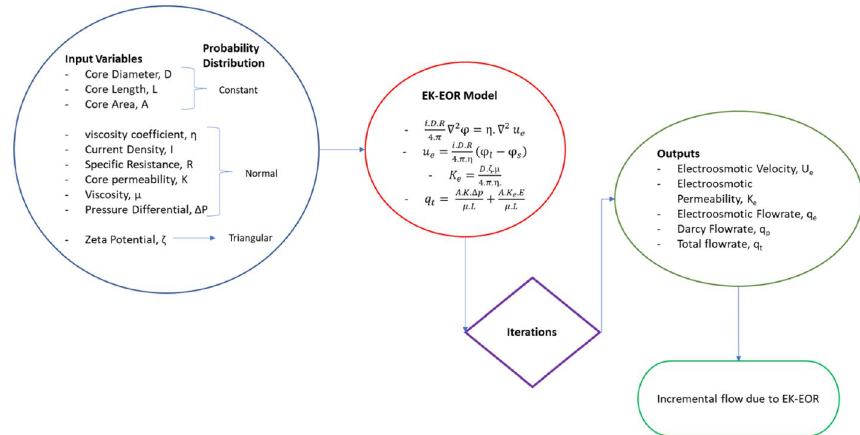
Fig. 5 Design of stochastic experiment